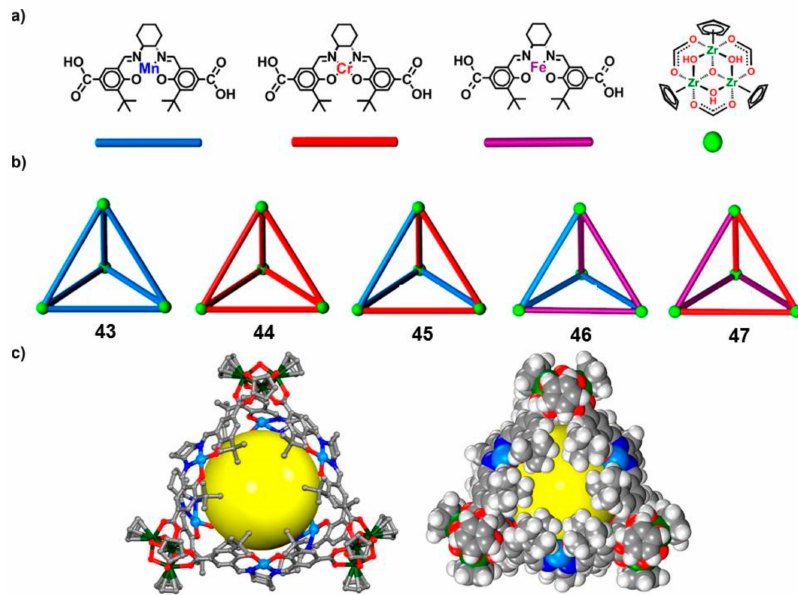
Figure 8. ( a ) Chemical structures of the metallosalen complexes and trimetallic clusters. ( b ) Schematic representations of nanocages 43 – 47 . ( c ) X-Ray structure and space-filling representation of 43 (adapted with permission from Ref. [41]. Copyright 2008 American Chemical